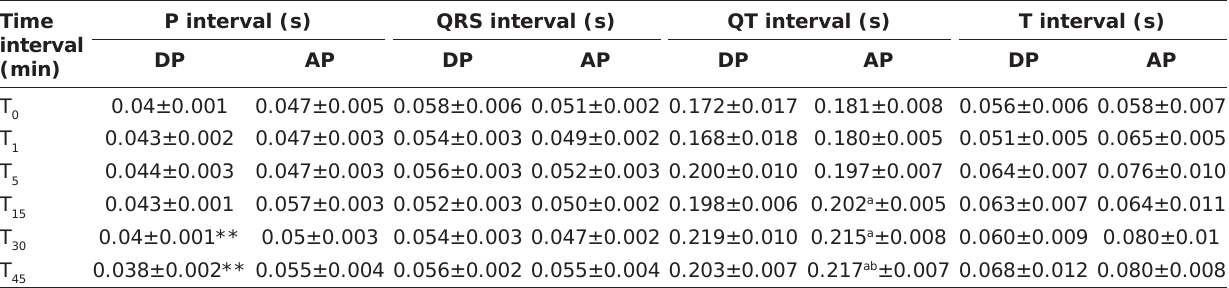
Table-4: Mean±SE values of ECG variables during anesthesia in group DP (n=10) and AP (n=10) at different time intervals in dogs. Time interval